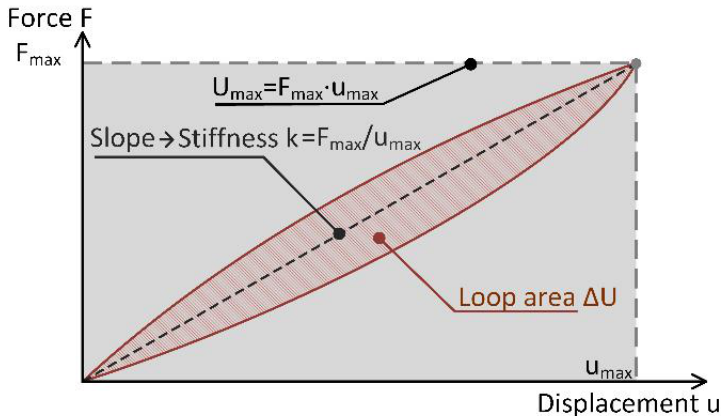
Figure 11. Graphical representation of relation between the U max and the stiffness k .